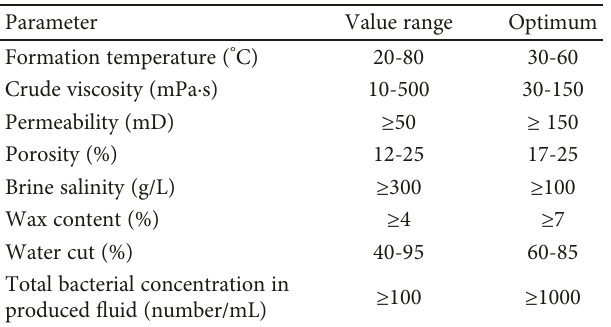
Figure 9: (a) The microbial growth and peeling-o ff oil fi lm [13]. (b) The peeling-o ff course of oil droplet [13]. (c) A large amount of modular/ fl oss stopping big ori fi ces Table 2: CNPC MEOR reservoir screening parameter [5]. Table 3: MEOR reservoir screen parameter in Shengli oil fi eld [14].